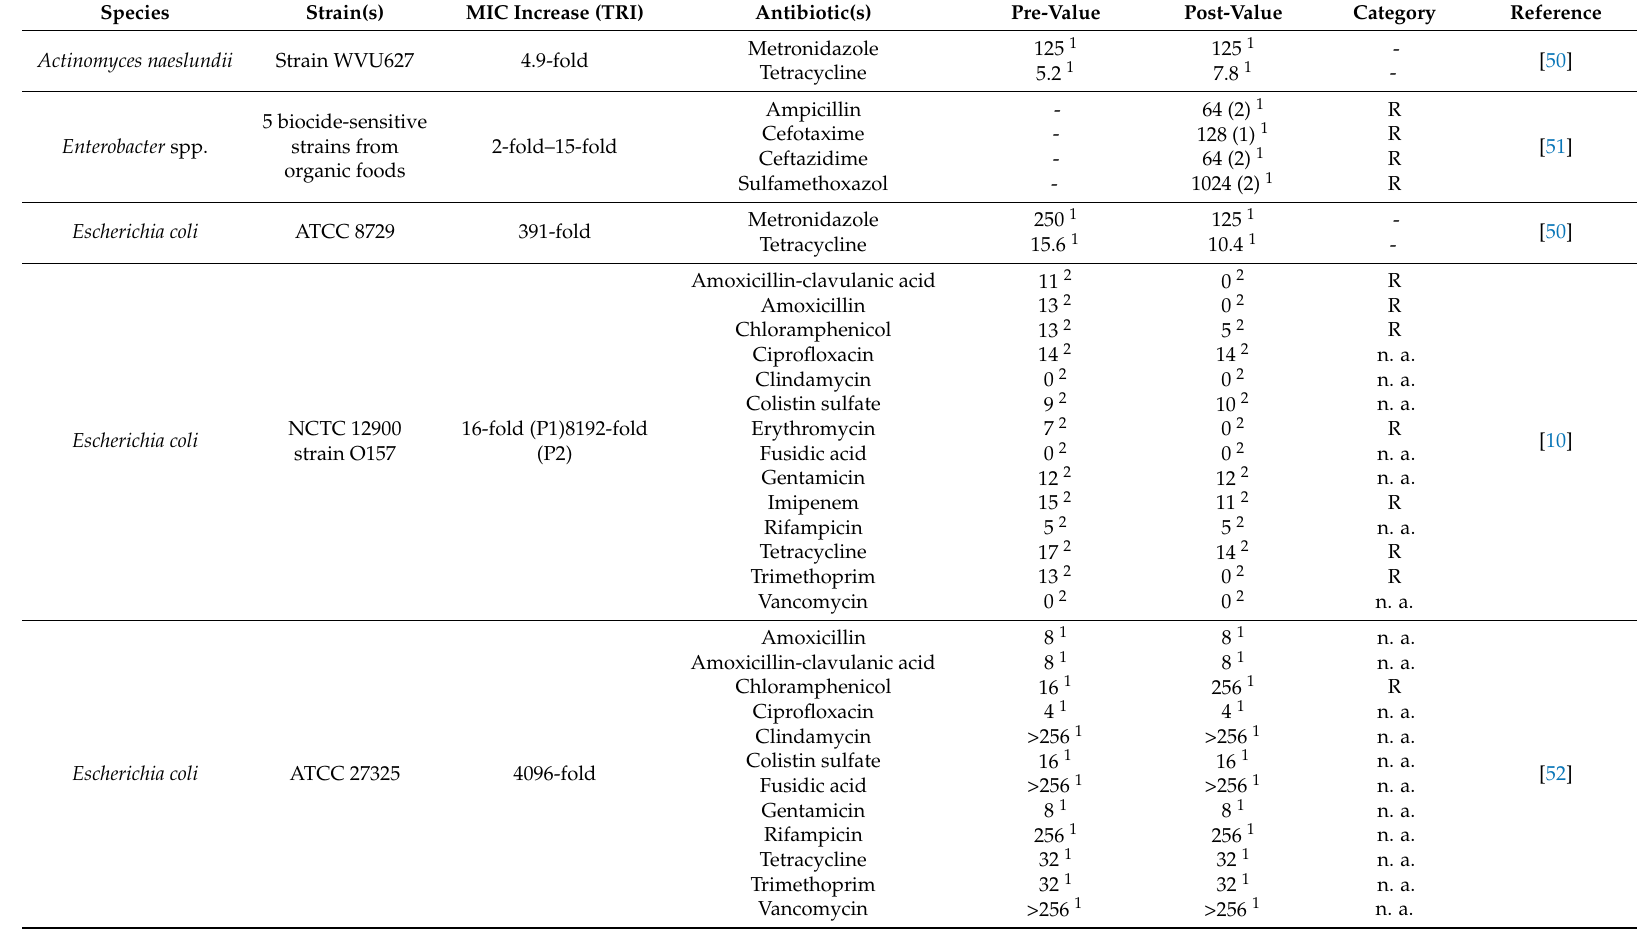
Table 4. Gram-negative species with antibiotic resistance after various types of low level exposure (<MIC value) to triclosan